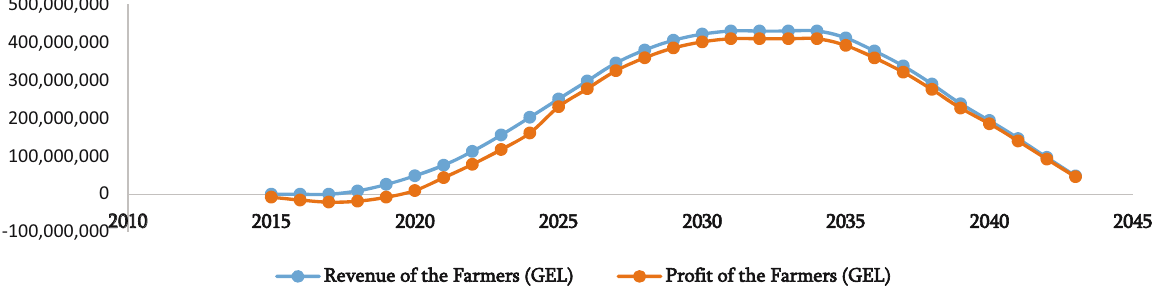
Figure 1: Revenue and pro fi t of the farmers ( 2015 – 2043 ) . Source: Authors ’